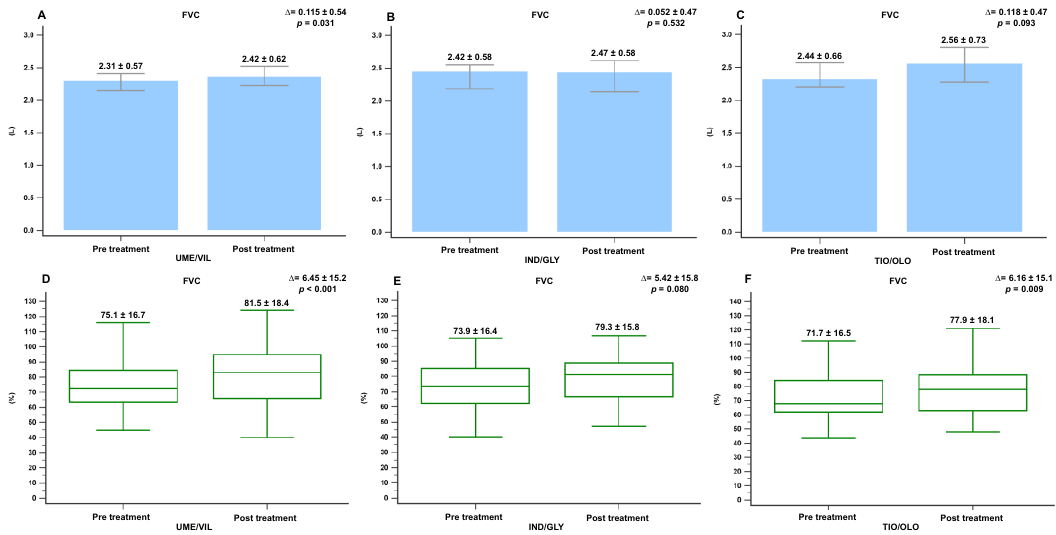
Figure 2. The significant difference in FEV1(L) and FEV1(%) in COPD patients before and after 12 months of treatment with medications ( A ) FEV1(L) in UMEC/VIL, ( B ) FEV1(L) in IND/GLY, ( C ) FEV1(L) in TIO/OLO, ( D ) FEV1(%) in UMEC/VIL, ( E ) FEV1(%) in IND/GLY, and ( F ) FEV1(%) in TIO/OLO. Data were presented as mean and standard deviation.